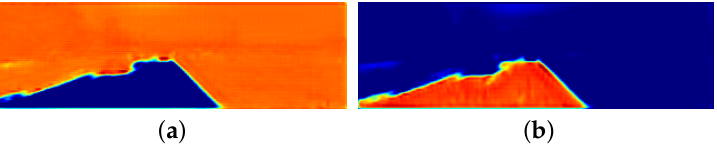
Figure 15. Model—ResNet-18, layer 107, total channels—32, type—convolutional layer. ( a ) Output of channel 1. ( b ) Output of channel 2. Uniform and accurate gradients. The predictions at these layers are almost similar to those of the output